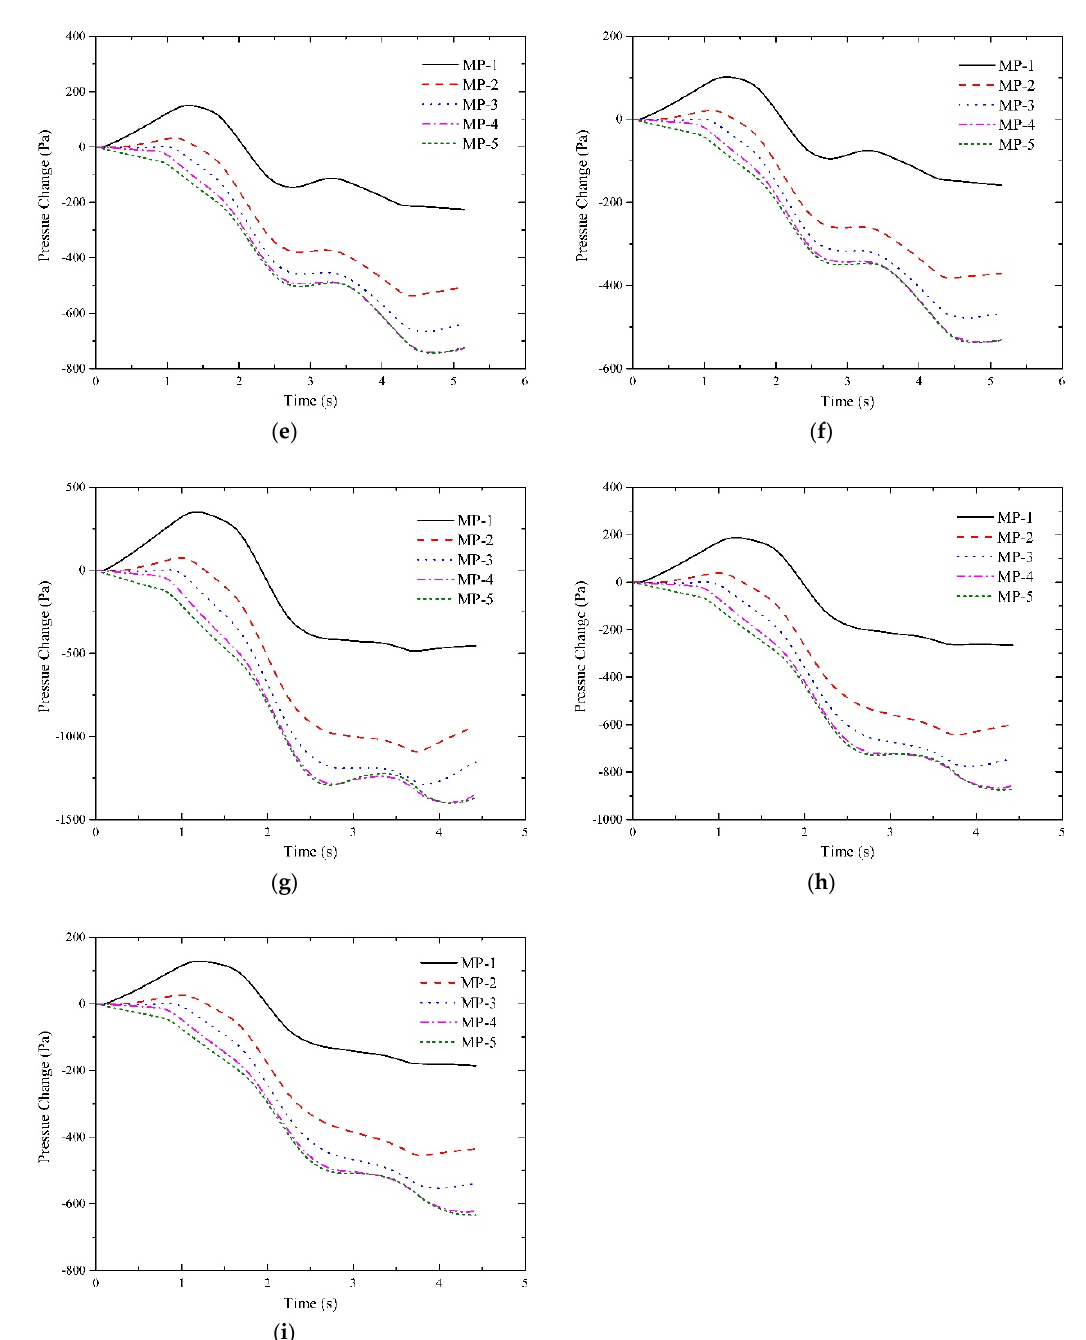
Figure 5. The interior pressure changes at different operation speed and seal indexes of train body. ( a ) S-4 at 250 km/h; ( b ) S-8 at 250 km/h; ( c ) S-12 at 250 km/h; ( d ) S-4 at 300 km/h; ( e ) S-8 at 300 km/h; ( f ) S-12 at 300 km/h, ( g ) S-4 at 350 km/h; ( h ) S-8 at 350 km/h; ( i ) S-12 at 350 km/h.